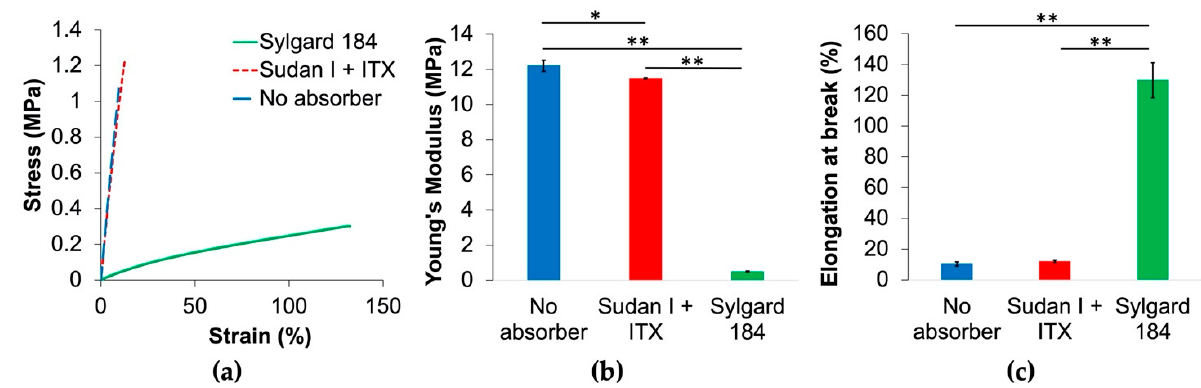
Figure 6. ( a ) Stress–strain curve from tensile testing of Sylgard 184 (green), Sudan I + ITX resin (red), and no absorber resin (blue); ( b ) Young’s modulus of the same three materials; ( c ) elongation at break for each material. In ( b , c ), a one-way ANOVA test was performed to determine statistical significance. A single asterisk (*) signifies p < 0.05, and a double asterisk (**) signifies p < 0.01 for post hoc Tukey’s test between groups. Error bars represent the standard error of mean ( n = 5).